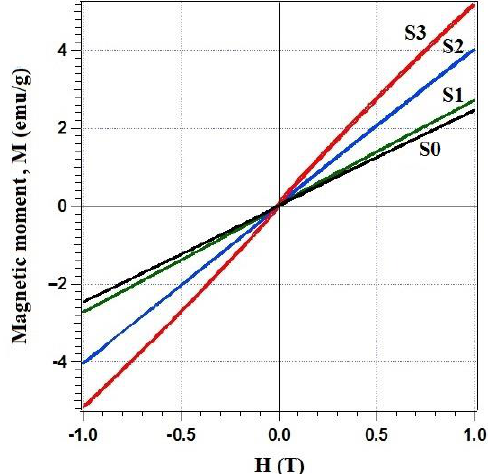
Figure 4. The curve for magnetization, M to magnetic field, H from sample LaMnO 3 (S0), La 0.9 Ba 0.1 MnO 3 (S1),